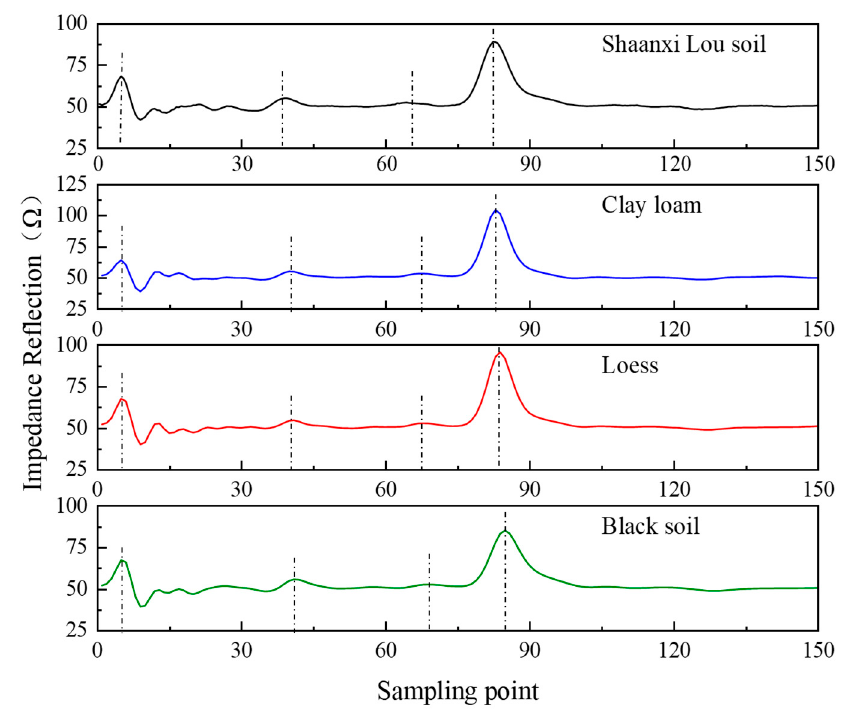
Figure 6. Three-layer soil infiltration line test.